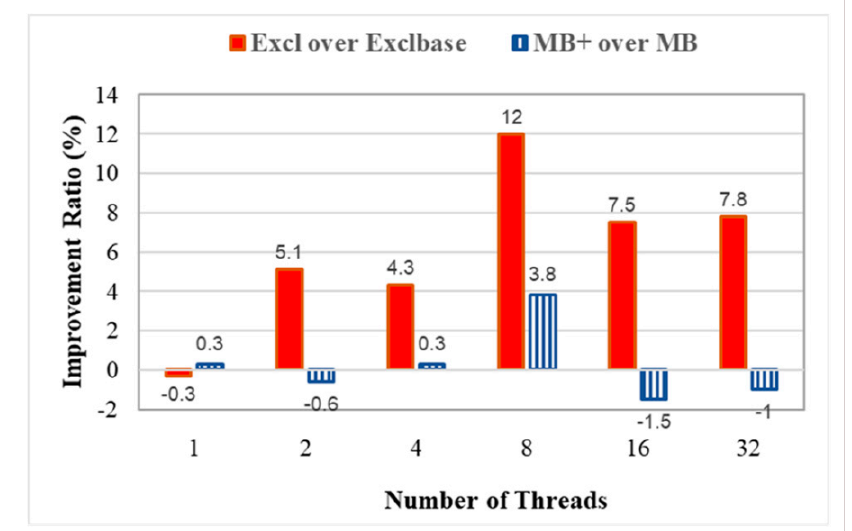
Figure 12. Improvement ratio for enhancing the task selection